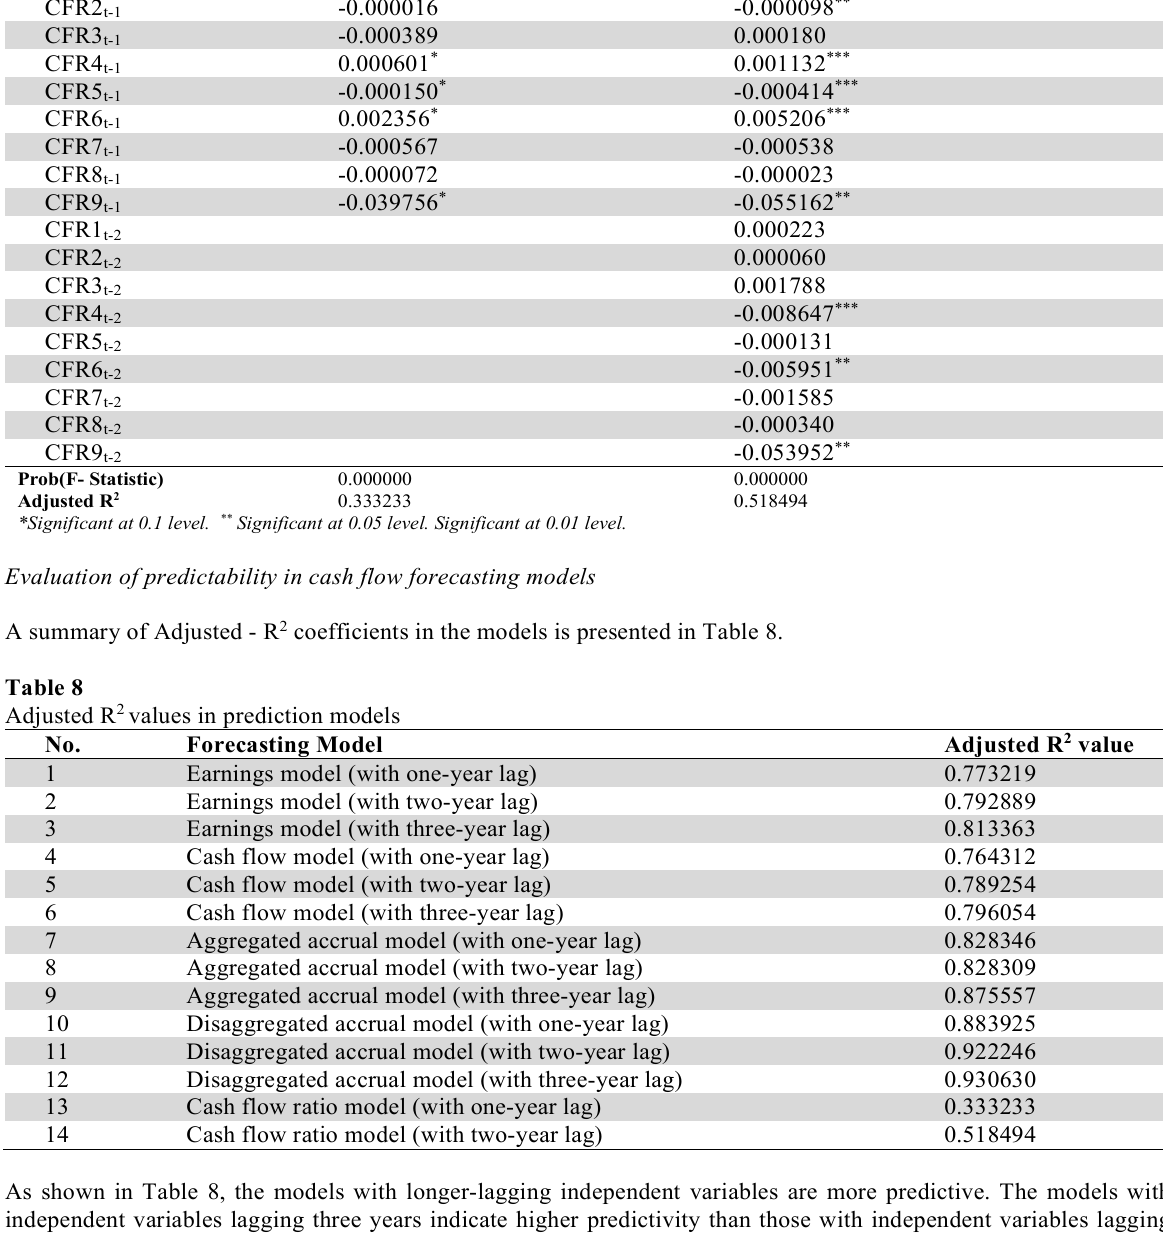
Summary of FEM regression results of the cash flow ratio model